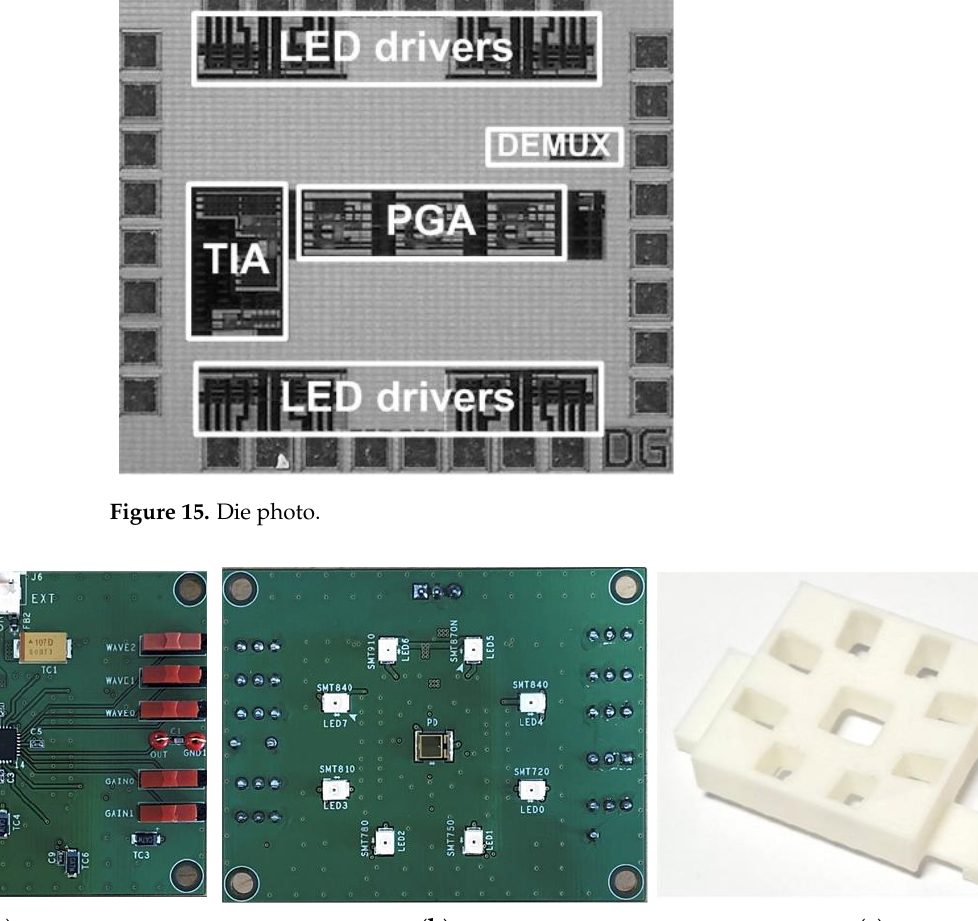
Figure 17. Sugar content measurement setup using the implemented NIR spectroscopy module.